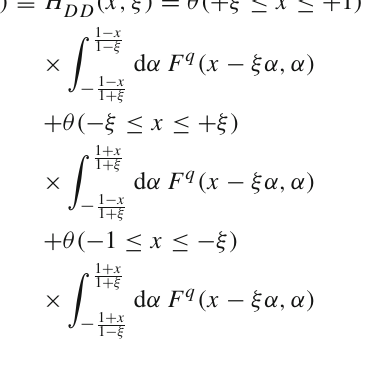
[see Eqs. (35), (36) 0